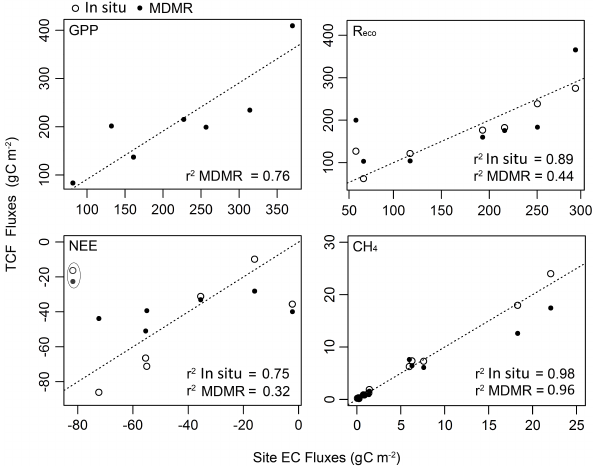
Fig. 3. Correspondence between TCF model and tower EC records for cumulative (gCm − 2 ) GPP, R eco , NEE, and CH 4 fluxes from six pan-Arctic tower locations. The TCF model simulations include those derived from in situ measurements (open circles) or MODIS remote sensing and MERRA reanalysis inputs (MDMR; in black). A 1:1 relationship is indicated by the dashed line. The r 2 agree- ment is significant at a 0.05 probability level, except for MDMR- based R eco and NEE ( p = 0 . 16 and 0.27), and excludes NEE fluxes for KY (circled) due to large differences in the CO 2 response rela- tive to the other